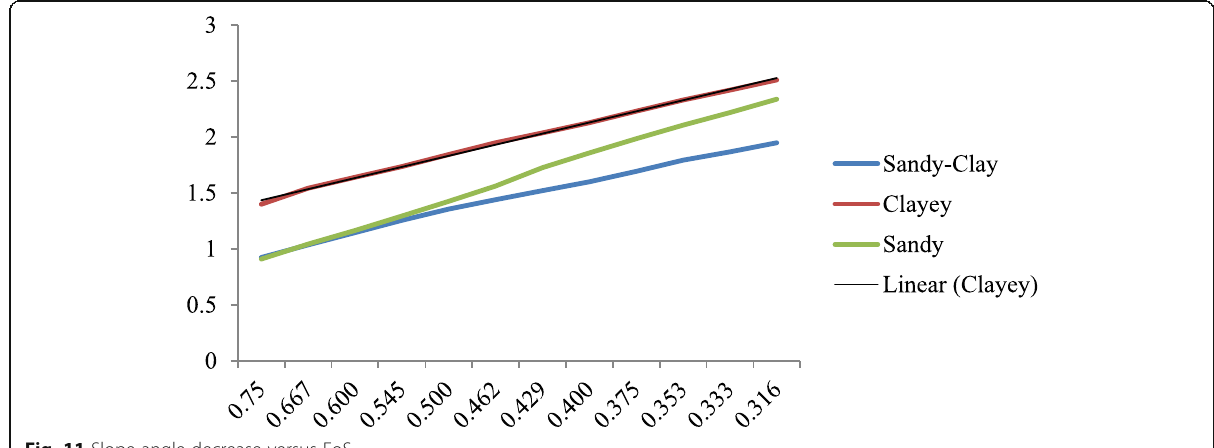
Fig. 11 Slope angle decrease versus FoS